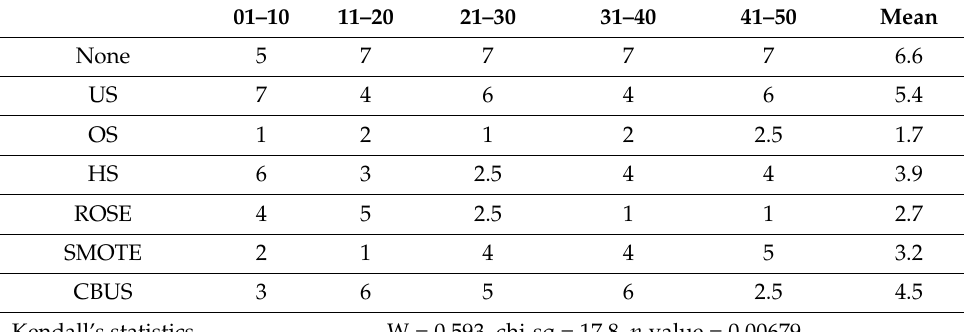
Table 16. Ranks of DBT for kNN for varying levels of IR.